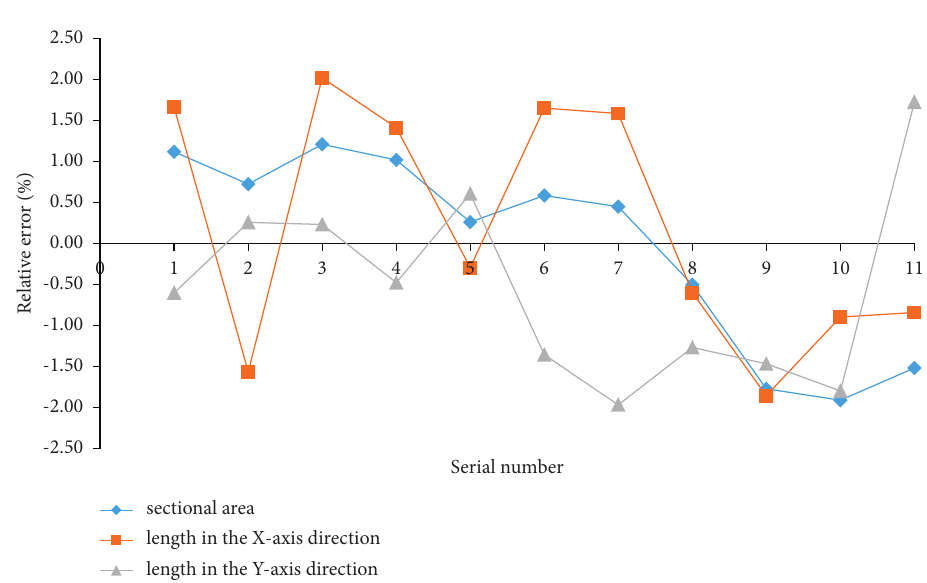
Figure 11: Relative error of sectional area and